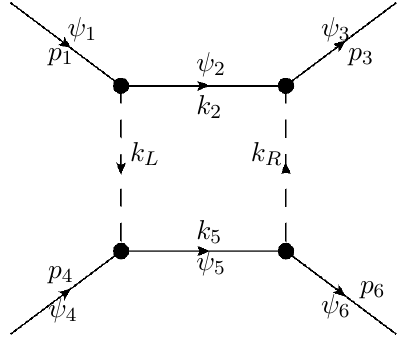
Figure 4 . Box diagram that generates the e(cid:11)ective four-fermion operator